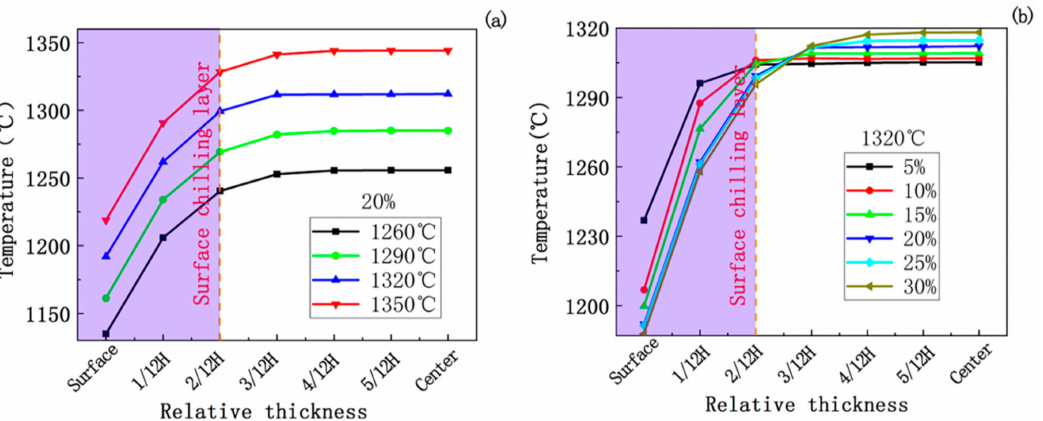
Figure 8. Effect on temperature distribution along the thickness direction at the exit: ( a ) different initial rolling temperatures at a fixed reduction, and ( b ) different reductions at a constant initial